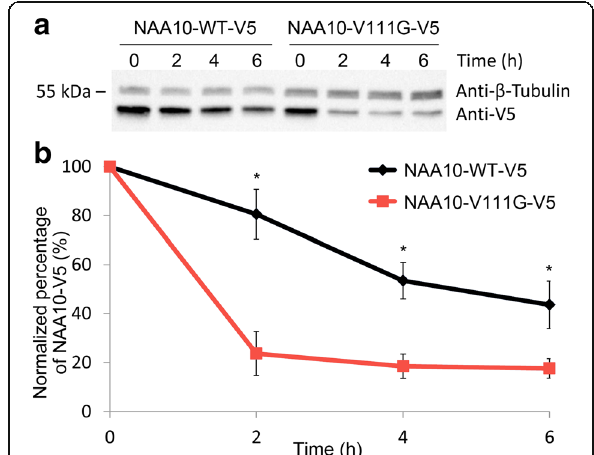
Fig. 4 Cycloheximide chase experiments. a Western blot showing the protein levels of overexpressed NAA10-WT-V5 and NAA10- V111G-V5 before and 2, 4 and 6 h after protein synthesis was stopped by the addition of cycloheximide. b Quantification of NAA10-V5 bands from cycloheximide chase experiments. Western blots from 6 independent experiments were quantified using Imagelab 3.0 from Biorad, and the intensities in each band 2, 4 and 6 h after cycloheximide treatment were correlated both to the loading control (anti- β -tubulin) and to the intensity in the band representing NAA10- V5 before cycloheximide treatment. Each curve represents the average levels of NAA10 from 6 independent experiments combined. * statistically significant ( p <0.0005, student